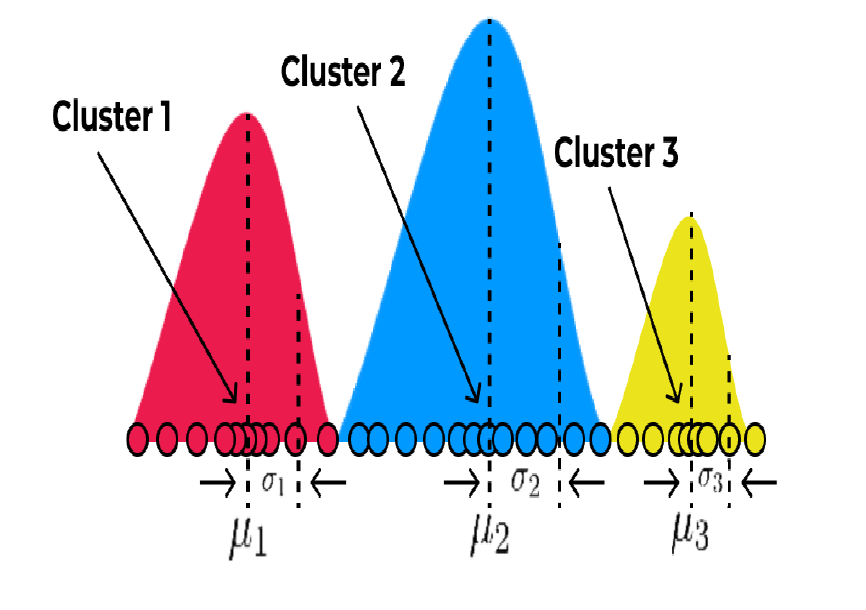
Figure 4. One-dimensional Gaussian mixture